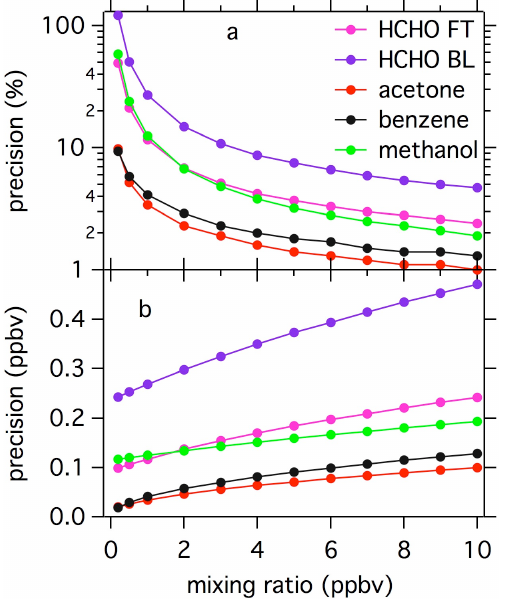
Figure 6: The noise calculated from counting statistics of the PTR-MS for HCHO in the free troposphere (FT) and the boundary layer (BL) together with methanol, acetone and benzene for typical backgrounds and sensitivities observed during CalNex2010: a) in percent as relative noise, b) in ppbv as absolute noise. Figure 5: a) Background subtracted raw signals from the in-flight calibration of the PTR-MS for HCHO during flights on April 20, April 21 and June 18, 2010 versus the inlet flow, which is proportional to the altitude. The color code represents the humidity (equivalent to the mass37/mass19 ratio). b) Laboratory and in-flight calibration of the PTR-MS for HCHO dependent on the humidity. A double exponential fit is used to describe the humidity dependence of the PTR-MS HCHO sensitivity.